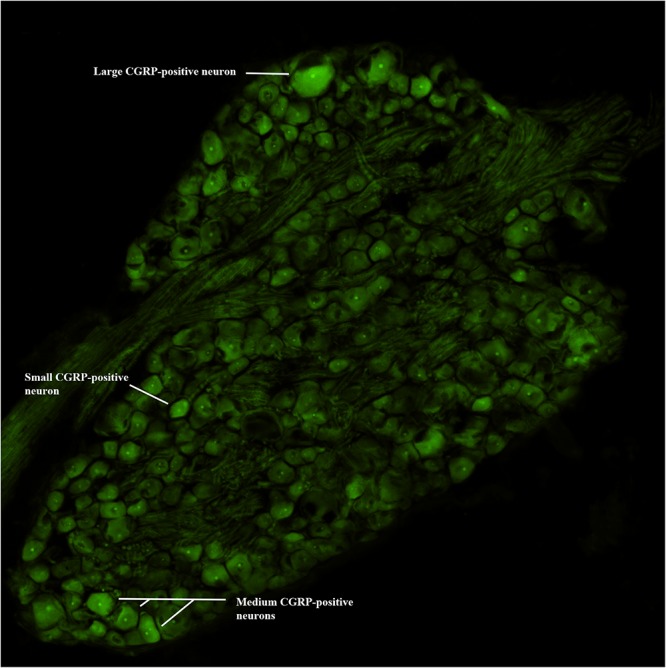
CGRP-immunofluorescence. Digital image of a lumbar DRG with examples of small, medium, and large CGRP-positive immunoreactive neurons.